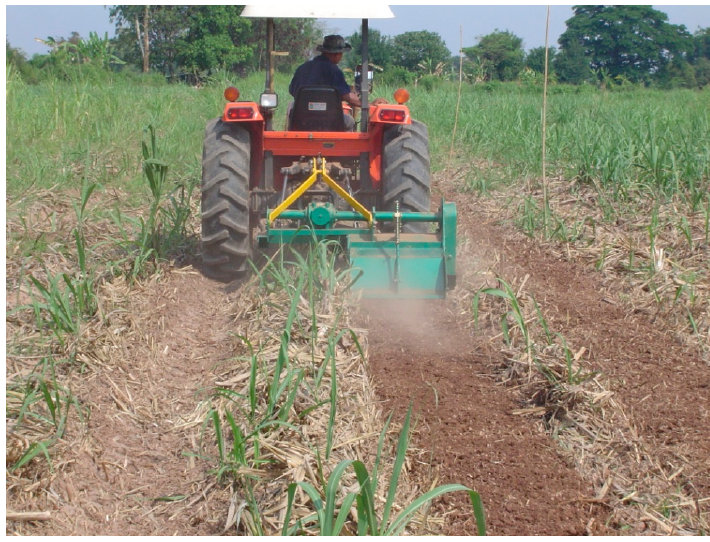
Figure 7. Sugarcane field after harvesting using the sugarcane harvester.